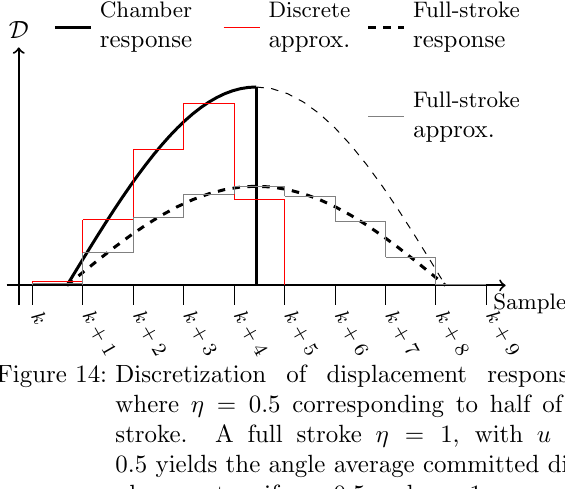
Figure 14: Discretization of displacement response, where η = 0 . 5 corresponding to half of a stroke. A full stroke η = 1, with u = 0 . 5 yields the angle average committed dis- placement as if η = 0 . 5 and u =